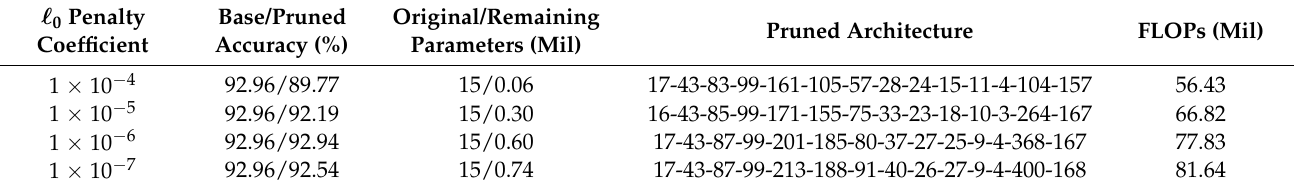
Table A7. The effect of the coefficient of (cid:96) 0 norm penalty on